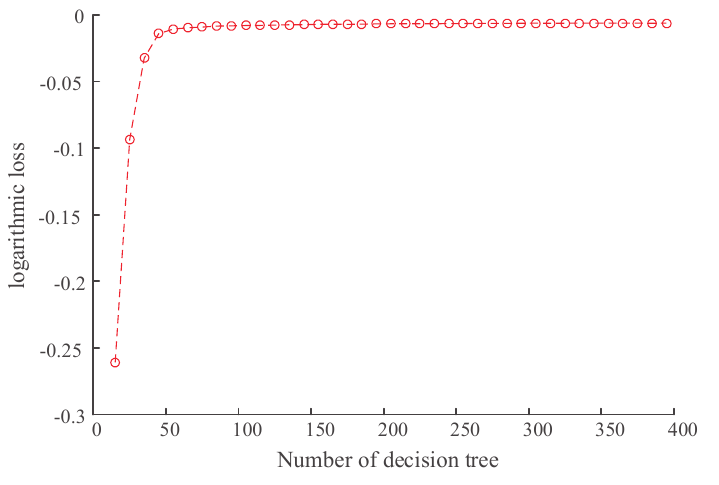
Figure 10. Determination of the number of trees.